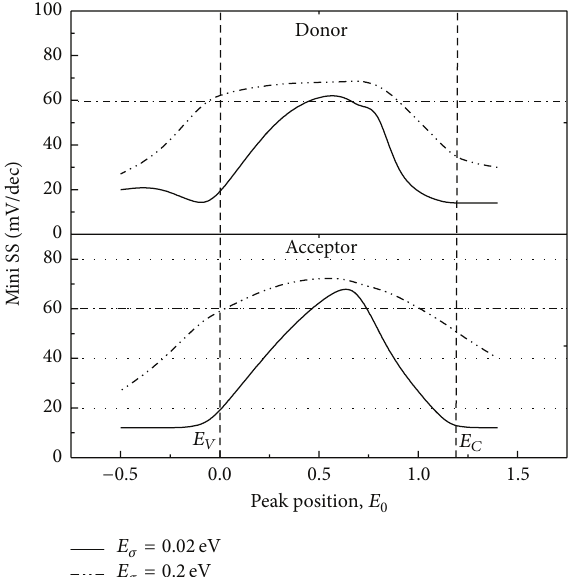
Figure 7: Mini SS is extracted as the minimum SS value in the interval between off-state and the threshold voltage 𝑉 peak position for DG-TFET at 𝑉